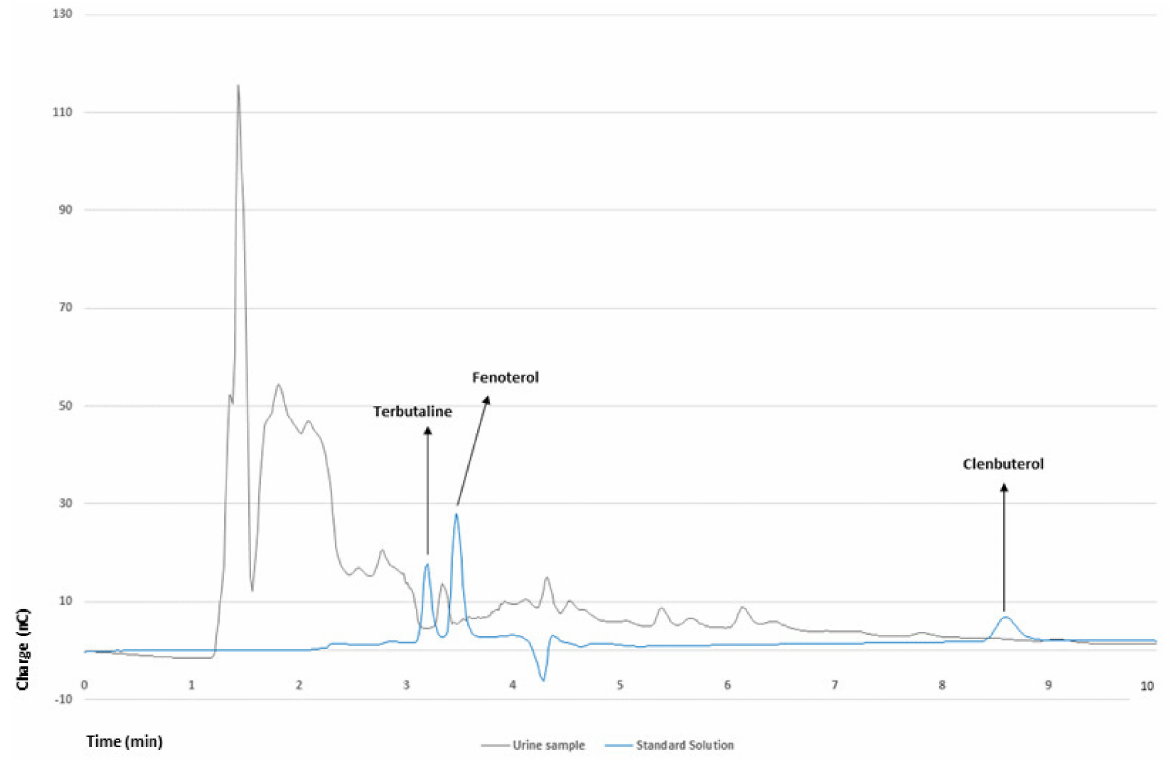
Figure 4. Comparison of chromatograms of a mixed standard solution of β -agonists, each at a concentration of 100 µ g.L − 1 (blue) and a calf urine sample purified by SPE (grey). Column LiChroCART C8 LiChrospher 60 RP-select B column (25 cm × 4 mm, 5 µ m I.D., Merck) coupled with a guard column LiChroCART LiChrospher 60 RP-select B (4 mm × 4 mm, 5 µ m I.D., Merck). Mobile phase: 20 mM of acetic acid/acetonitrile (55:45), pH 7.0. Flow rate 1.0 mL.min − 1 . Injection volume: 25 µ L. Detection: PAD at a glassy carbon